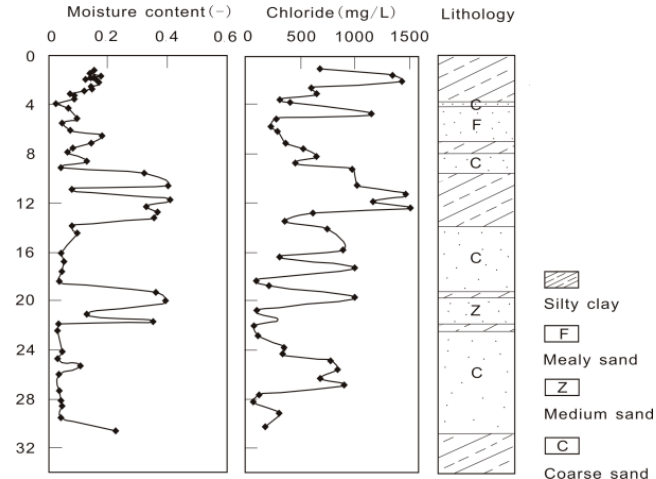
Figure 4. Cl − concentration, soil moisture content and lithology profiles at the ZD site.